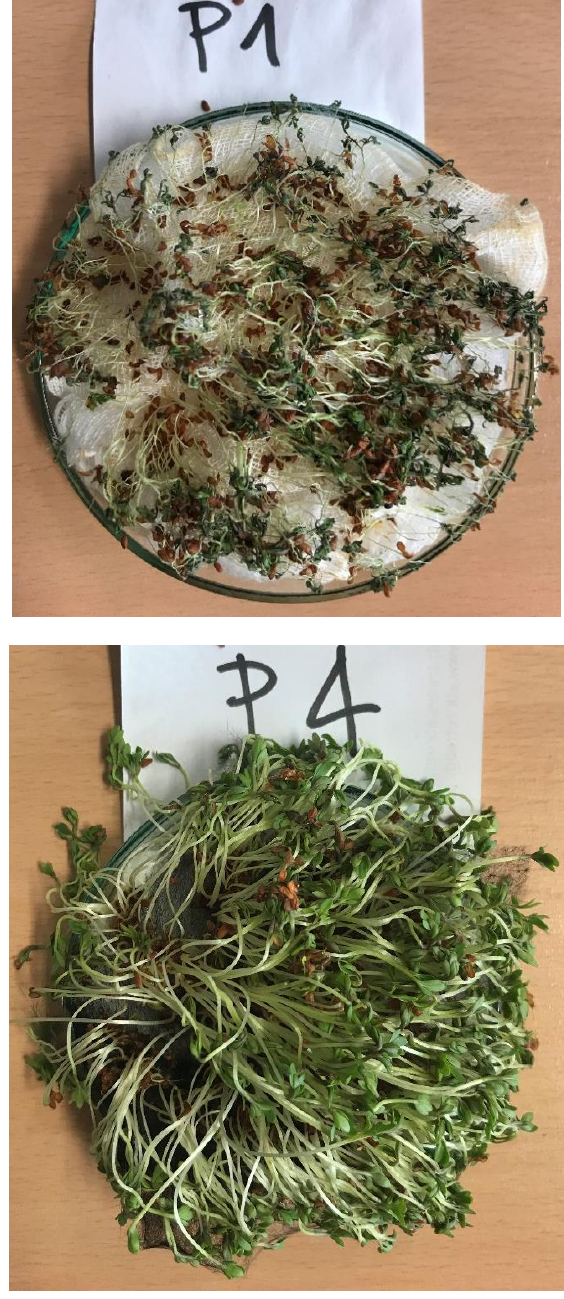
Fig. 4. Hierarchical structure of Nanoveil, a non-woven fabric made of carbon fibers with a layer of carbon nanotubes on the surface